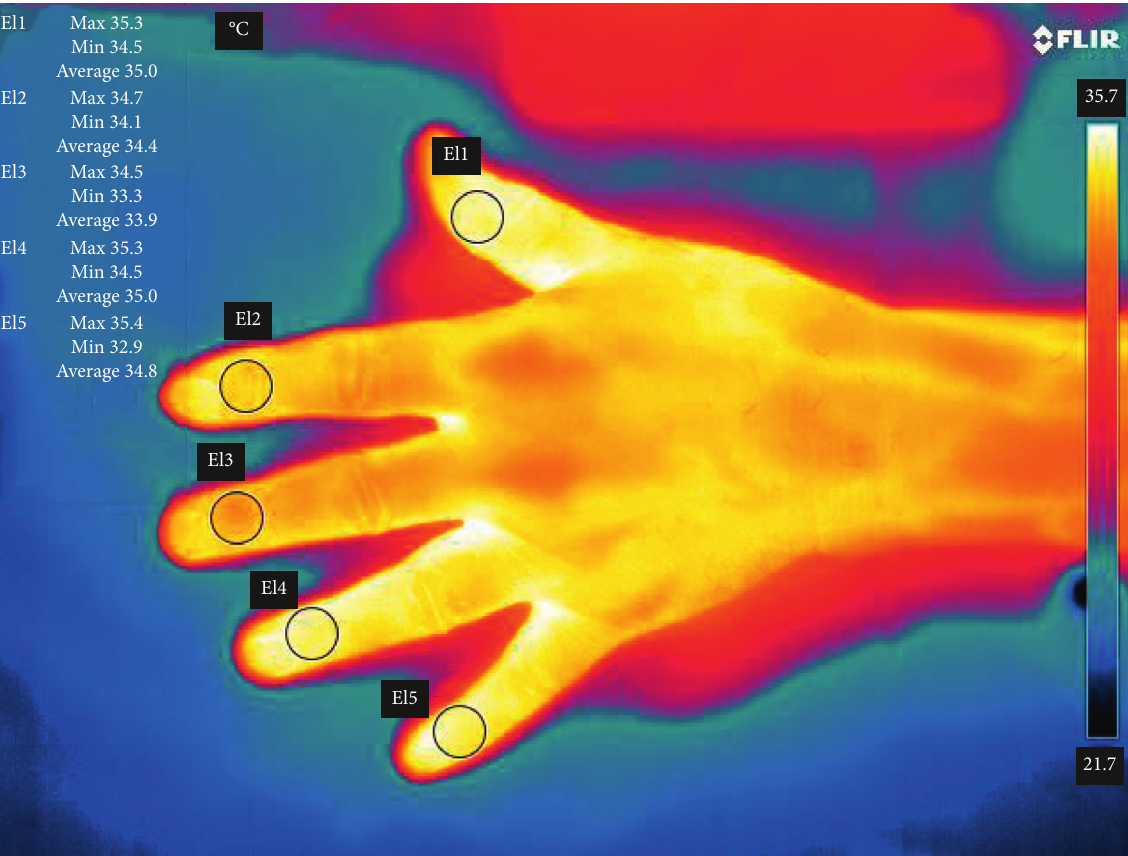
Figure 3: Thermographic image of a participant’s hand. The circles represent the area in which the software calculates the mean temperature outlined in the left table. The circles were placed manually within the FLIR computer program. To the right, a scale of colors indicates that yellow and white symbolize warmer temperatures than blue and black.